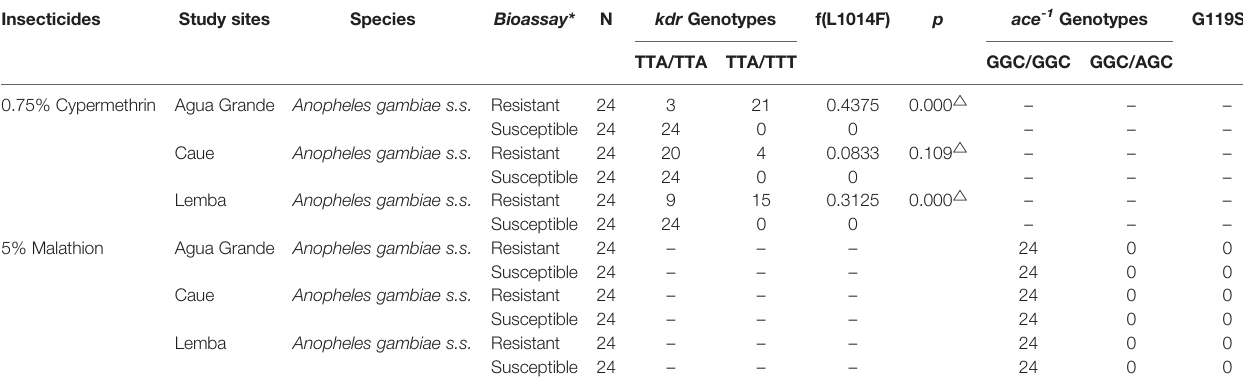
TABLE 5 | Distribution and Resistant allele frequencies in Anopheles gambiae s.s. in study sites from São Tome ́ and Pr ı ́ ncipe. Insecticides Study